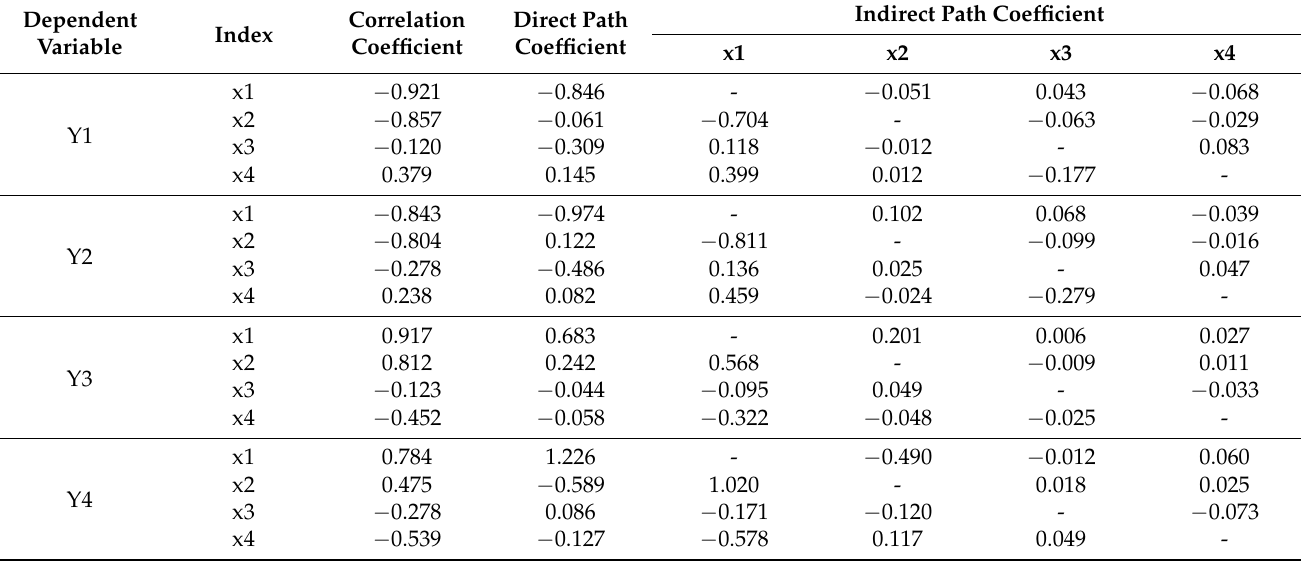
Table 8. Path analysis of dewatering rate and grain water index of bract and cob before and after physiological